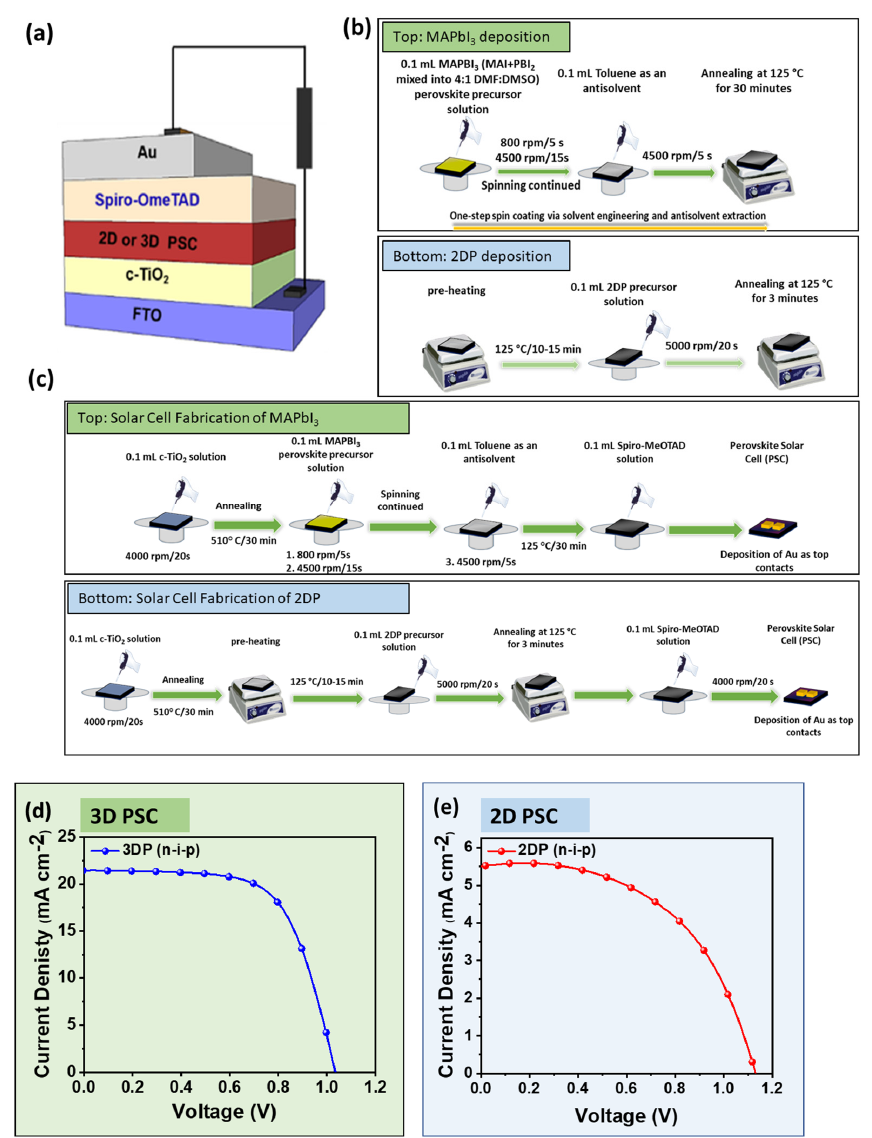
Figure 4. ( a ) The n ‐ i ‐ p architecture was used for our 3DP (MAPbI 3 ) and 2DP (CH 3 (CH 2 ) 3 NH 3 ) 2 (CH 3 NH 3 ) 3 Pb 4 I 13 PSC fabrication process. ( b ) Deposition procedure and